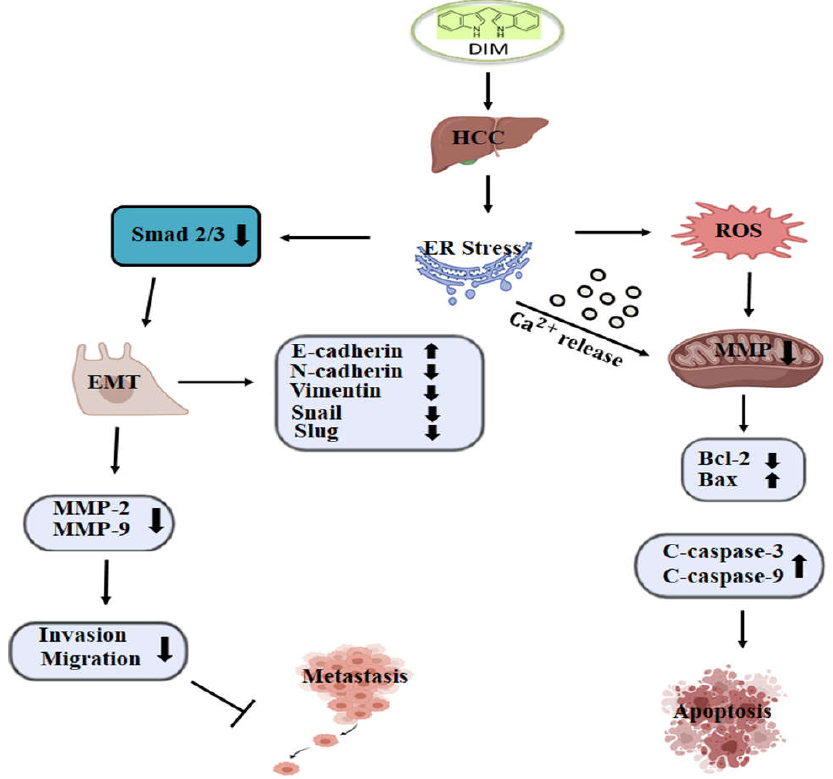
Figure 9. Graphical representation of proposed mechanisms by which DIM induces apoptosis and inhibits metastasis in HCC. DIM induces ER stress, accumulation of ROS, and Ca 2+ release into the cytosol, which acts on the mitochondria and causes a loss of mitochondrial membrane potential, leading to the activation of hepatic cell death. DIM-mediated ER stress also modulates the Smad2/3 pathway, inhibits EMT, and reduces cell invasion and migration ability, thus suppressing cancer metastasis.